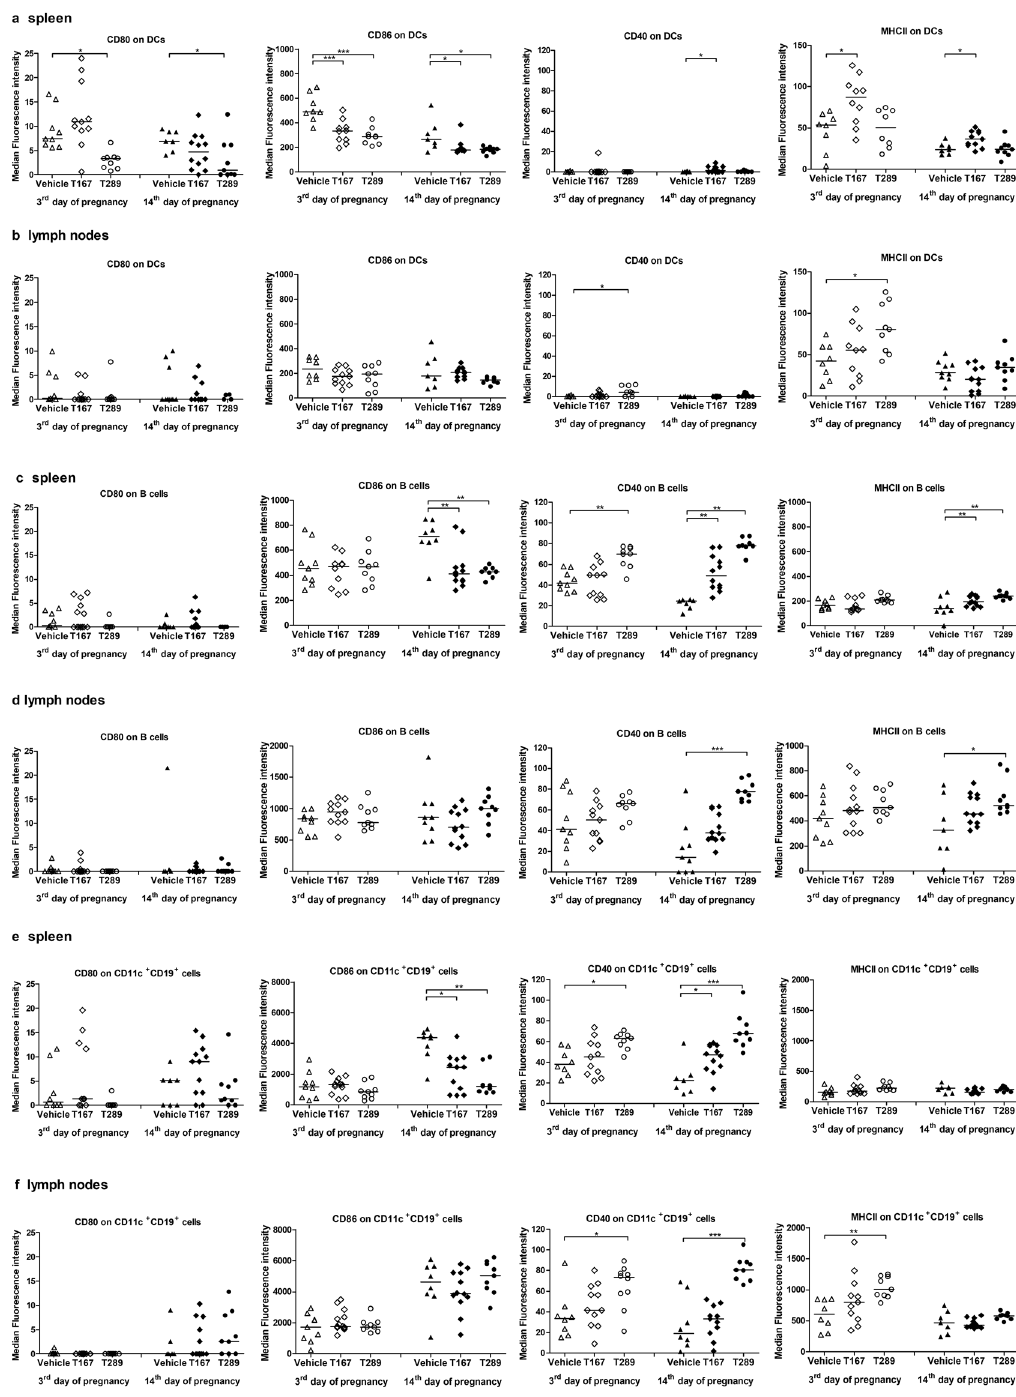
Figure 5. Effect of tregitope treatment on the expression of costimulatory molecules on antigen-presenting cells in abortion-prone mice. The data shown the specific fluorescence intensity of CD40, CD80, CD86 and MHC class II proteins on the surfaces of CD11c + (a) splenocytes and (b) uterine-draining lymph node cells, CD19 + (c) splenocytes and (d) uterine-draining lymph node cells and CD11c + CD19 + (e) splenocytes and (f) uterine-draining lymph node cells at the 3 rd and 14 th days of pregnancy. The data were analysed by one-way ANOVA (normal distribution) or the Kruskal-Wallis test (non-normal distribution) with Dunn’s multiple comparison post hoc test (P < 0.05) and are presented as individual values with median (at 14dpc n = 12 for T167, n = 9 for T289, n = 9 for Vehicle; at 3dpc n = 11 for T167, n = 11 for T289, n = 9 for Vehicle). * P < 0.05, ** P < 0.01, and *** P <